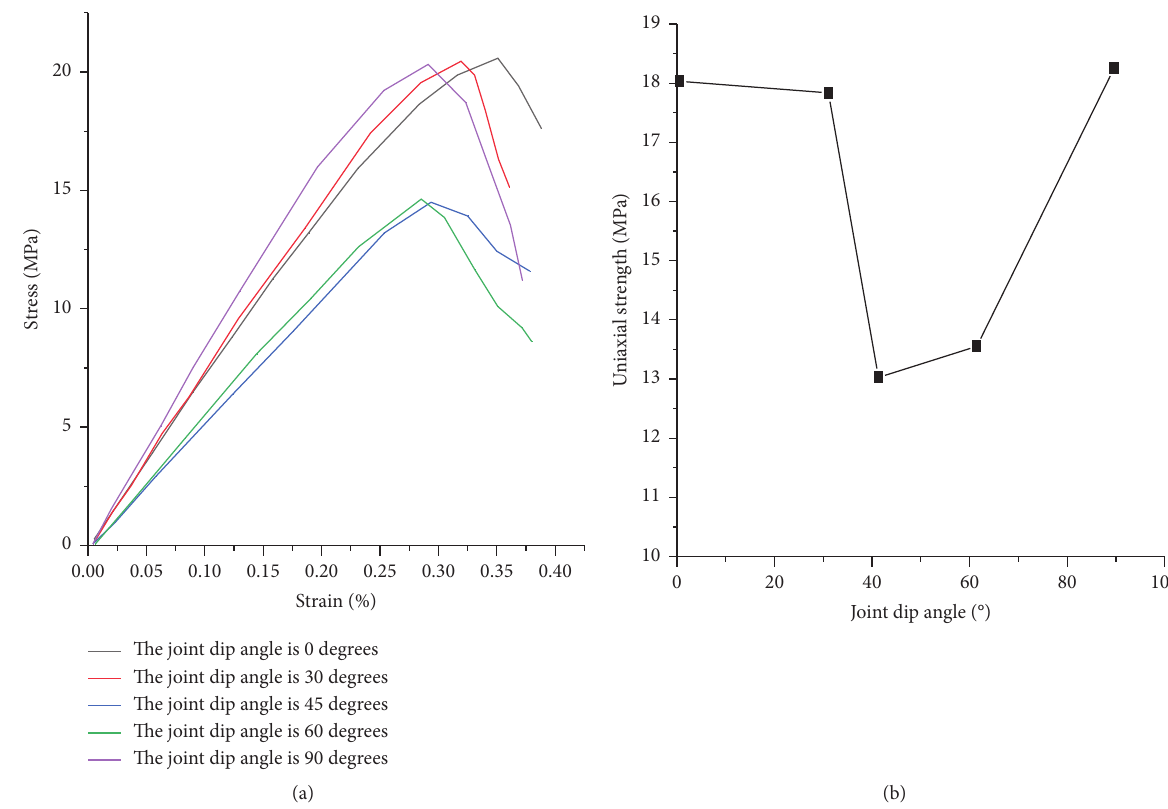
Figure 2: Influence of rock joint dip angle on uniaxial strength. (a) Uniaxial strength curve of different dip angles. (b) Rock strength under different dip angles.